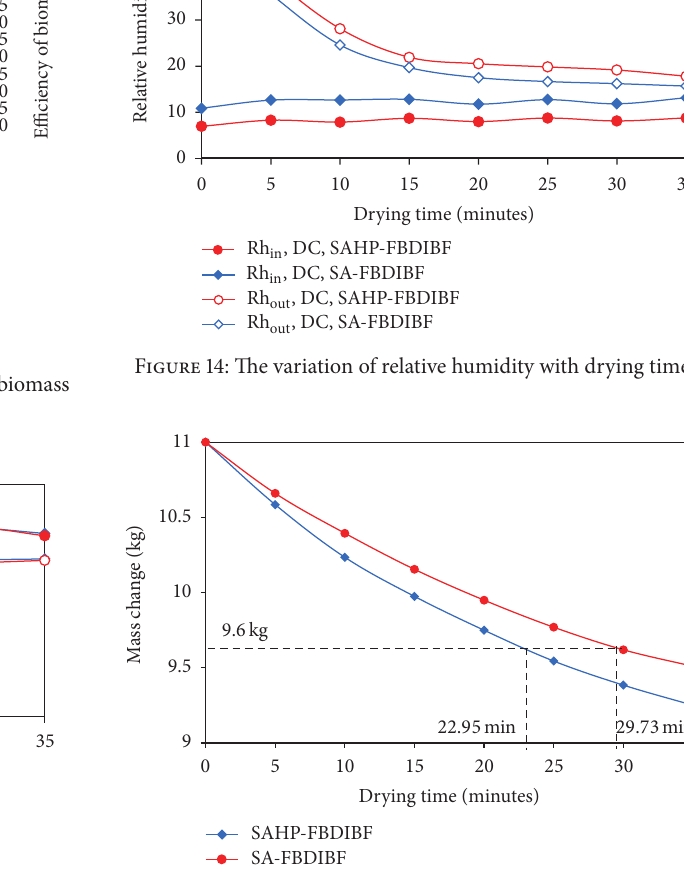
Figure 15: The variation of mass change with drying